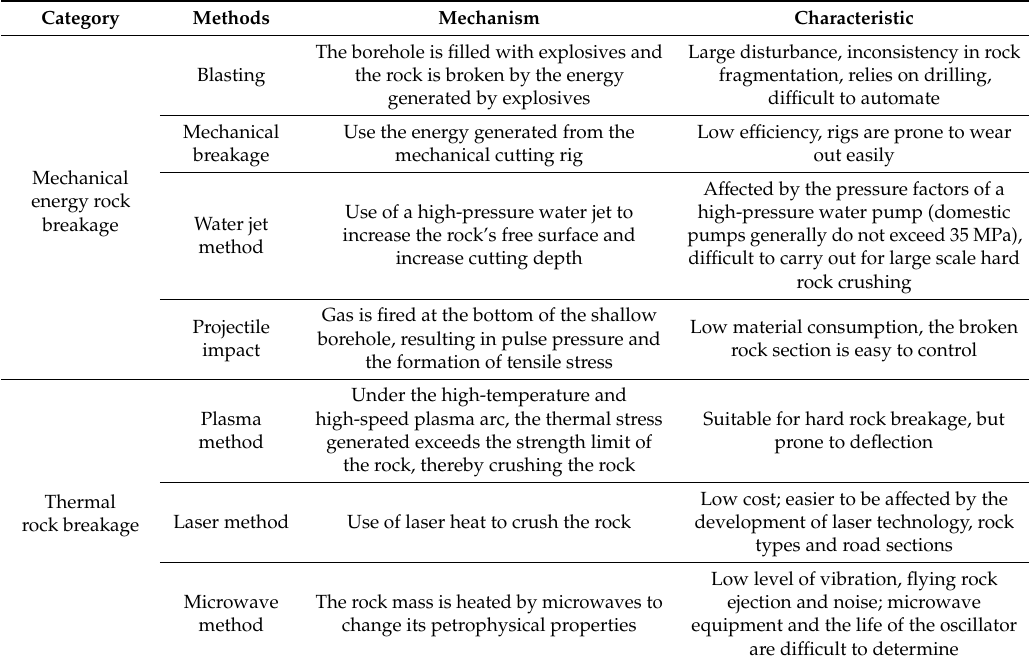
Table 1. Summary of rock breakage methods